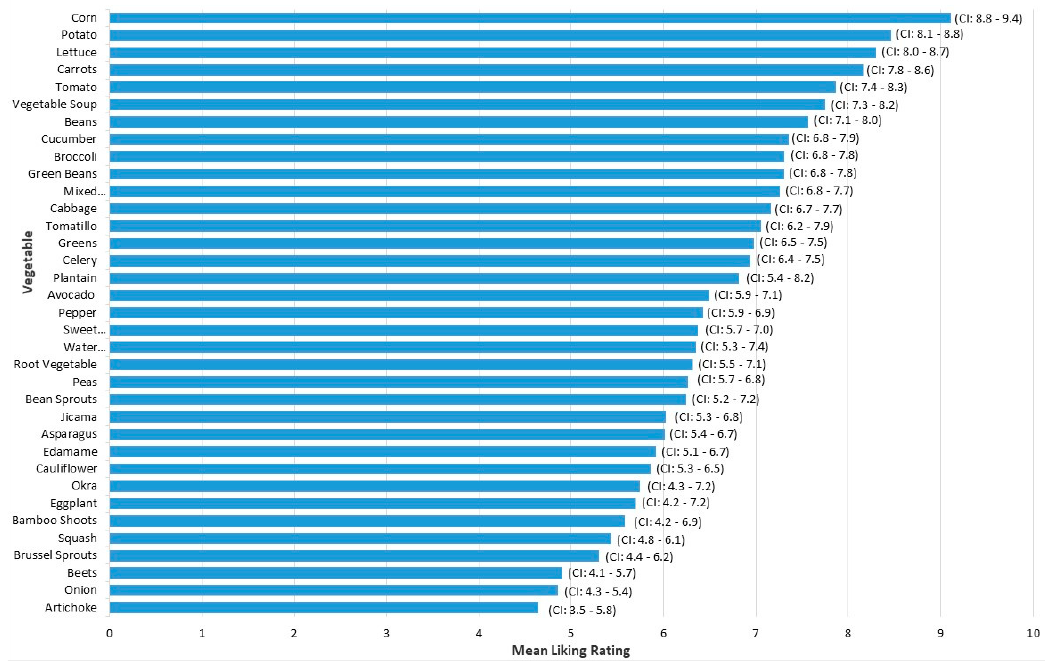
Figure 1. Mean liking ratings for children of 35 vegetables on a 10-point hedonic scale. Vegetables are in descending order from most liked (Corn) to least liked (Artichoke). Rating scale: 1 = Hate it, 5 = It’s okay, and 10 = Like it a lot. Standard error represented by error bars. CI is the 95% confidence interval around the mean.